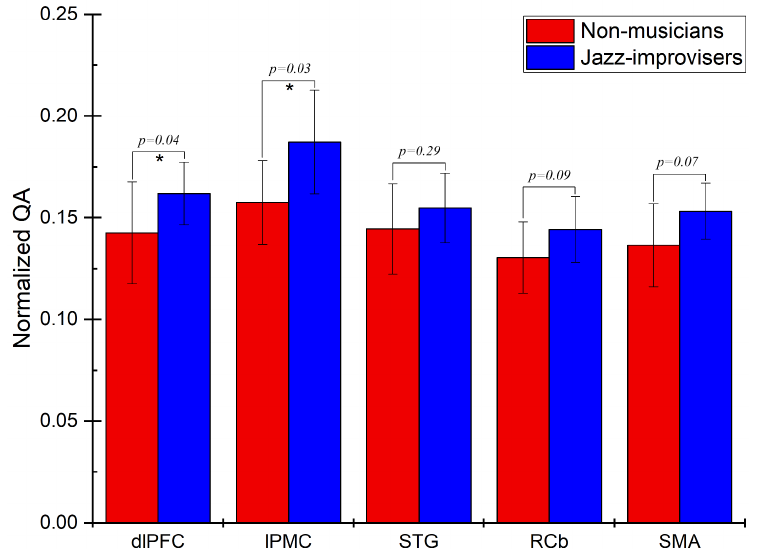
Figure 2. Region-based normalized quantitative anisotropy (NQA) for advanced jazz improvisers and non-musicians. Advanced jazz improvisers showed significantly higher NQA measures in frontal, and motor areas (dlPFC & lPMC), represented by a star * with the corresponding p -value